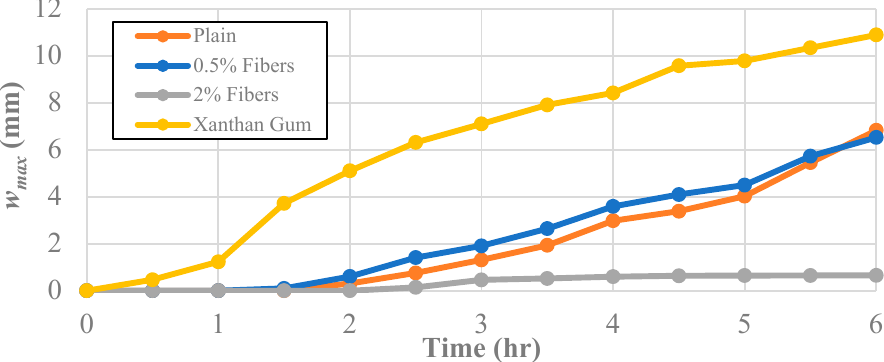
Figure 7. The effect of different additives on the maximum crack width, w max . The effect of the tested soil improvement additives on the average maximum crack length, l max , can be seen in Figure 8. Initially, the maximum crack length was taken to be the most prolonged individual crack, but once the crack patterns became more complex, the longest continuous path in the crack network that did not intersect itself was used to define the l max . The reason for studying the maximum crack length in each specimen was to examine the desiccation crack network and each improvement technique’s aptitude for preventing the initiation of new cracks. The maximum crack length at the end of the desiccation test for the untreated soil was 149 mm.